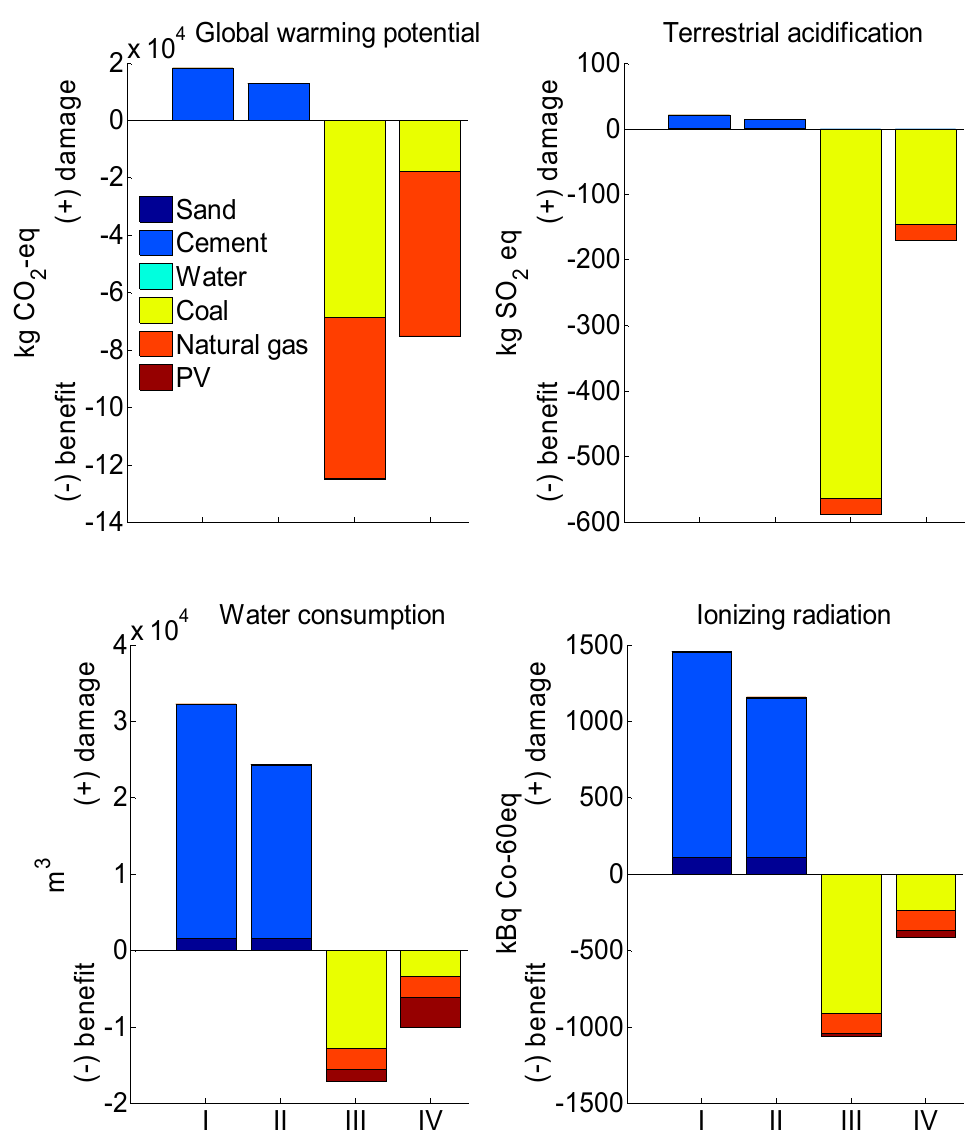
Figure 3. F1 sculptured tiles: damage and benefit impacts. I: CEM I Pdelta; II: CEM II Pdelta; III: 2020 OEdelta; IV: 2025 OEdelta. Evaluation was performed with ReCiPe2016 midpoint method, hierarchist (H) option.